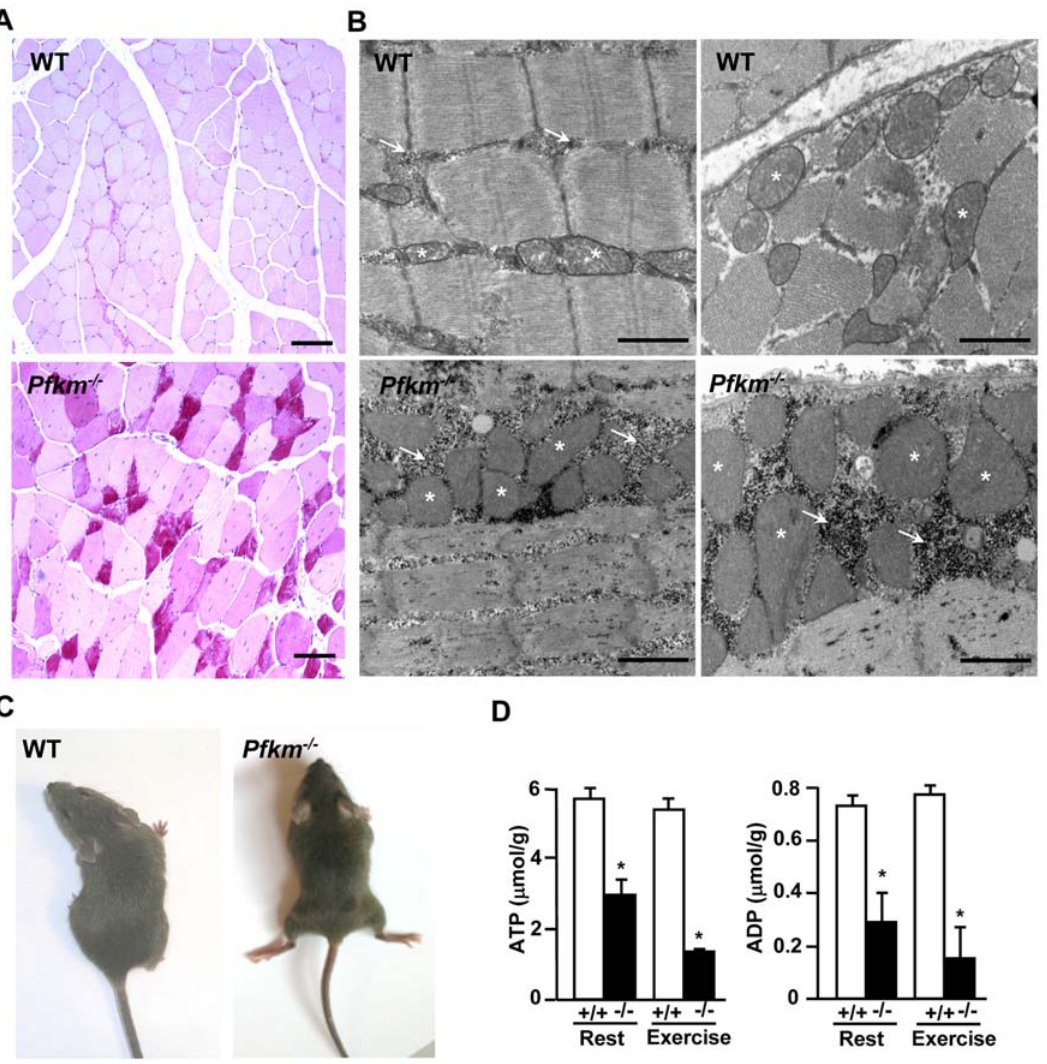
Figure 2. Pfkm 2 / 2 mice develop skeletal muscle glycogenosis and exercise intolerance. (A) Glycogen storage evidenced by PAS staining in skeletal muscle sections from wild-type (WT) and Pfkm 2 / 2 mice. Scale bar 50 m m. (B) Transmission electron microscopic analysis of skeletal muscle. Arrows show glycogen storage and asterisks point to mitochondria. Scale bar 1 m m. (C) Pfkm 2 / 2 mice showing severe muscle cramps after exercise (5 min). (D) ATP and ADP content was determined in perchloric extracts of skeletal muscle from wild-type ( + / + ) and and Pfkm 2 / 2 ( 2 / 2 ) mice, in rest and after exercise (5 min), as described in Materials and Methods. Results are mean 6 SEM of five mice per group. * P , 0.05 vs. wild-type.